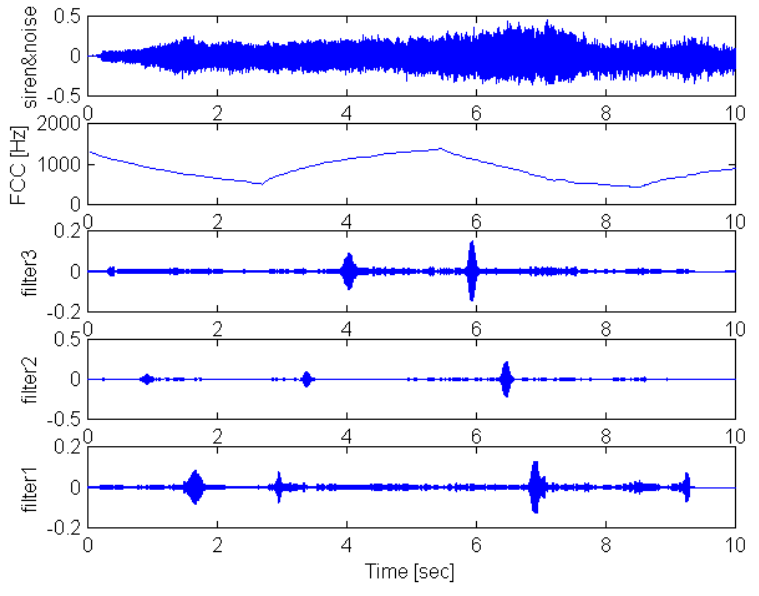
Figure 6. Activation of the three filters for a siren signal in the presence of traffic